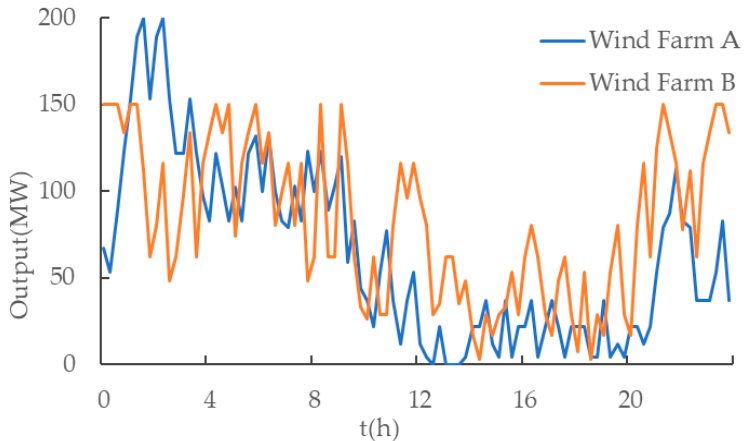
Figure 3. Total load curve of the IEEE-118 bus system.